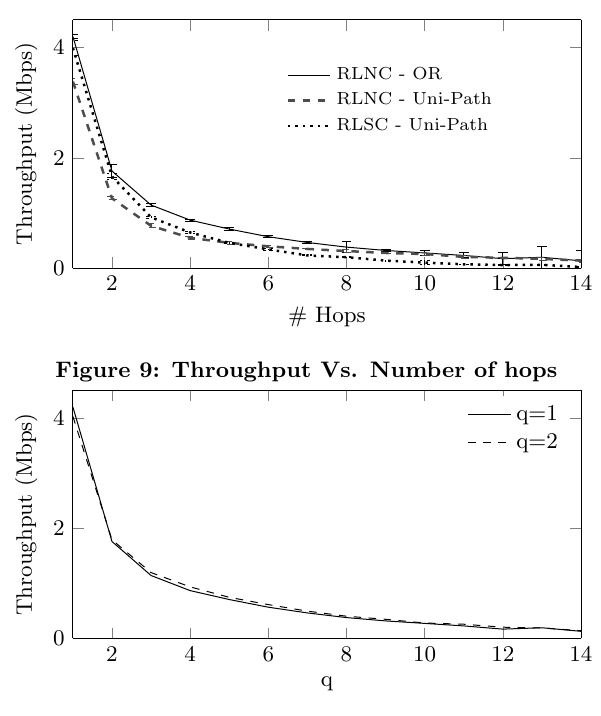
Figure 10: Throughput Vs. Number of hops for different q